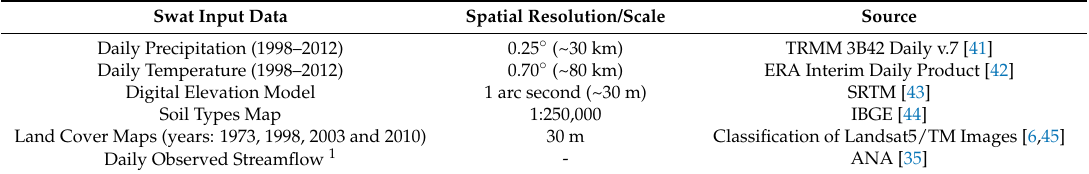
Table 1. Model Input